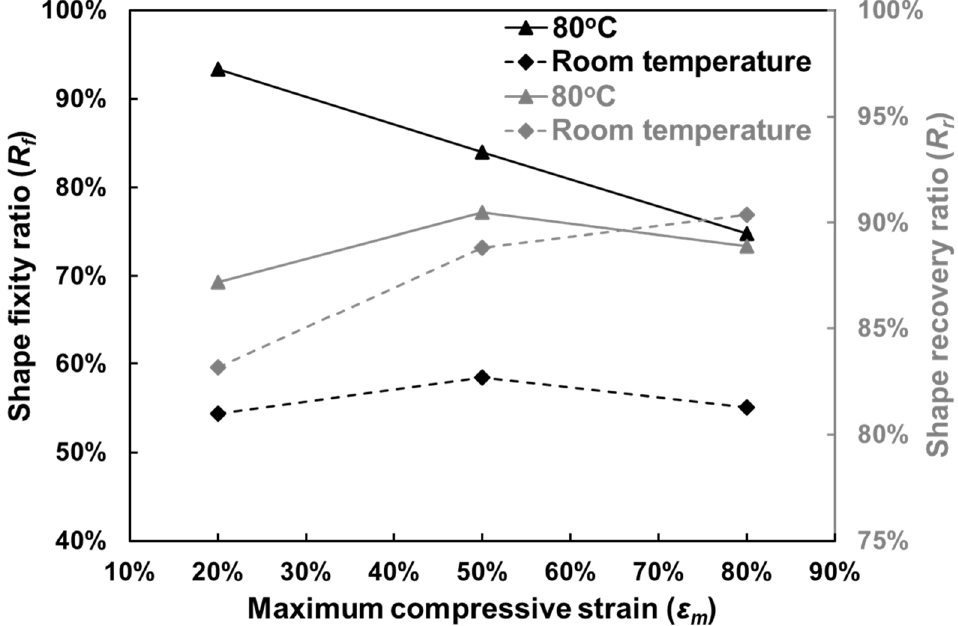
Figure 7. Shape fixity ratios (black color) and shape recovery ratios (grey color) of all tested samples as a function of ε m .